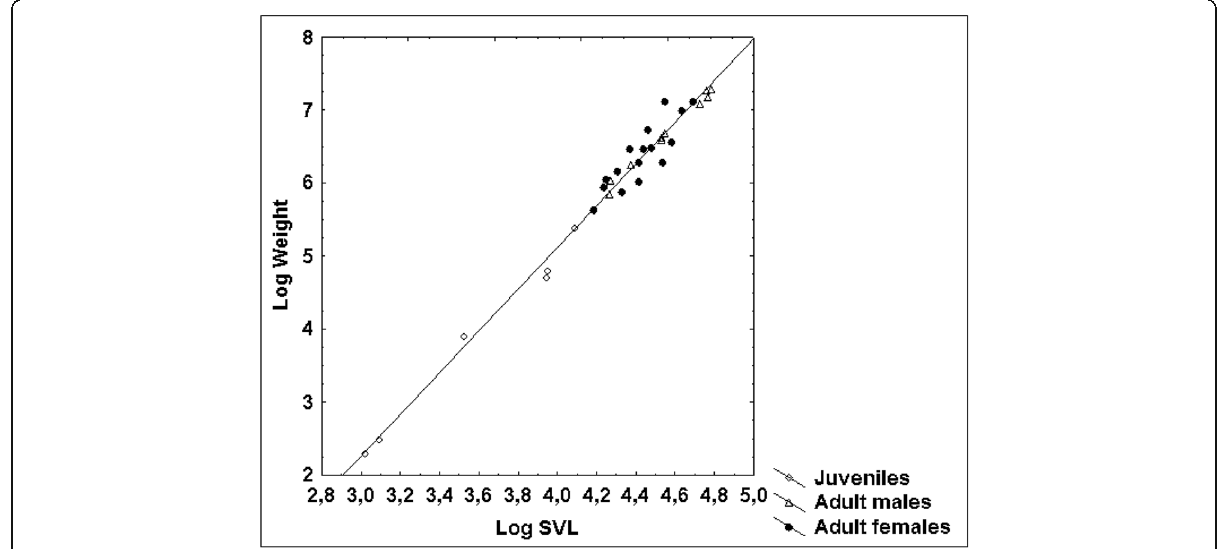
Fig. 6 Relationship between log-transformed SVL and log-transformed weight in 34 blunt-nosed vipers from Cyprus: Y = − 6.32 + 2.86*X. R 2 =